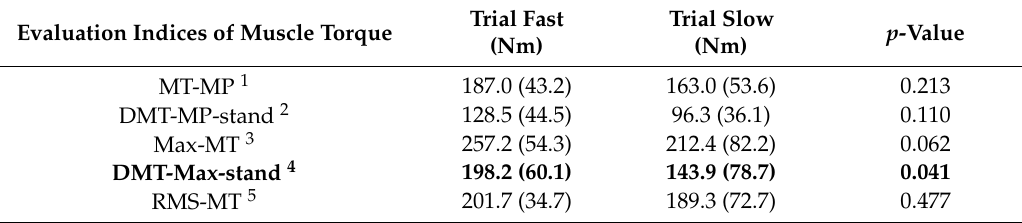
Table 2. Di ff erences in evaluated indices of muscle torque according to type of sit-to-stand (STS) motion ( N = 11).